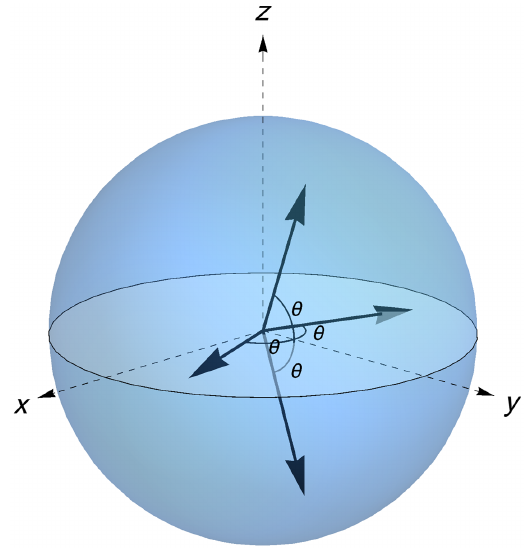
FIG. 4. Preparations S (α , θ) = { ρ r At θ = 0 all preparations are at α y . For θ = π/ 2, S = {− α x , α x , − α z , α z } , presenting the largest violation of inequal- ity (7).